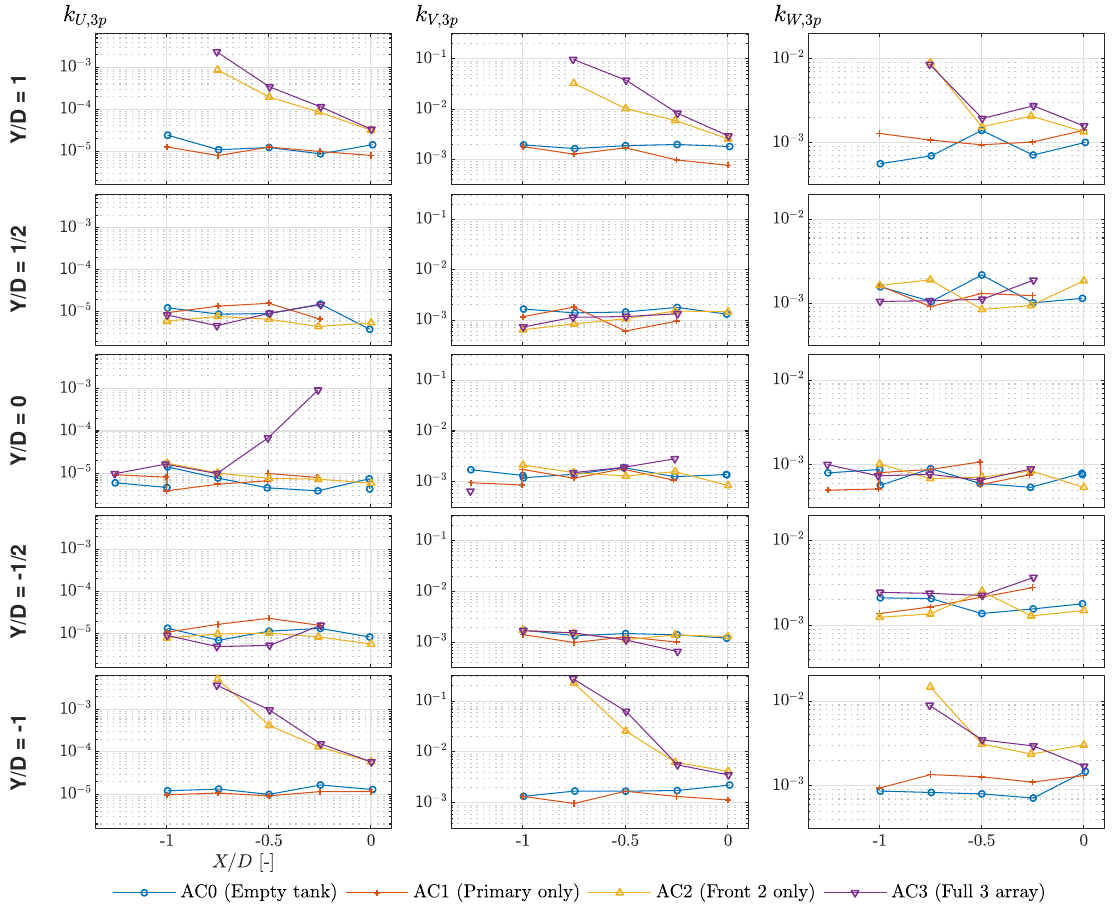
Figure 8. Relative energy content (defined by Equation (3)) at three times the rotational speed in U, V and W velocity components for various spatial locations. Shown for all array configurations defined in Figure